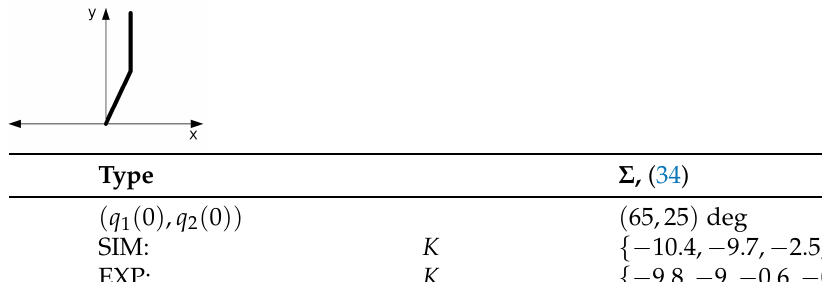
Table 6. Case A1: Initial posture of the Pendubot and parameters of the linear controller.